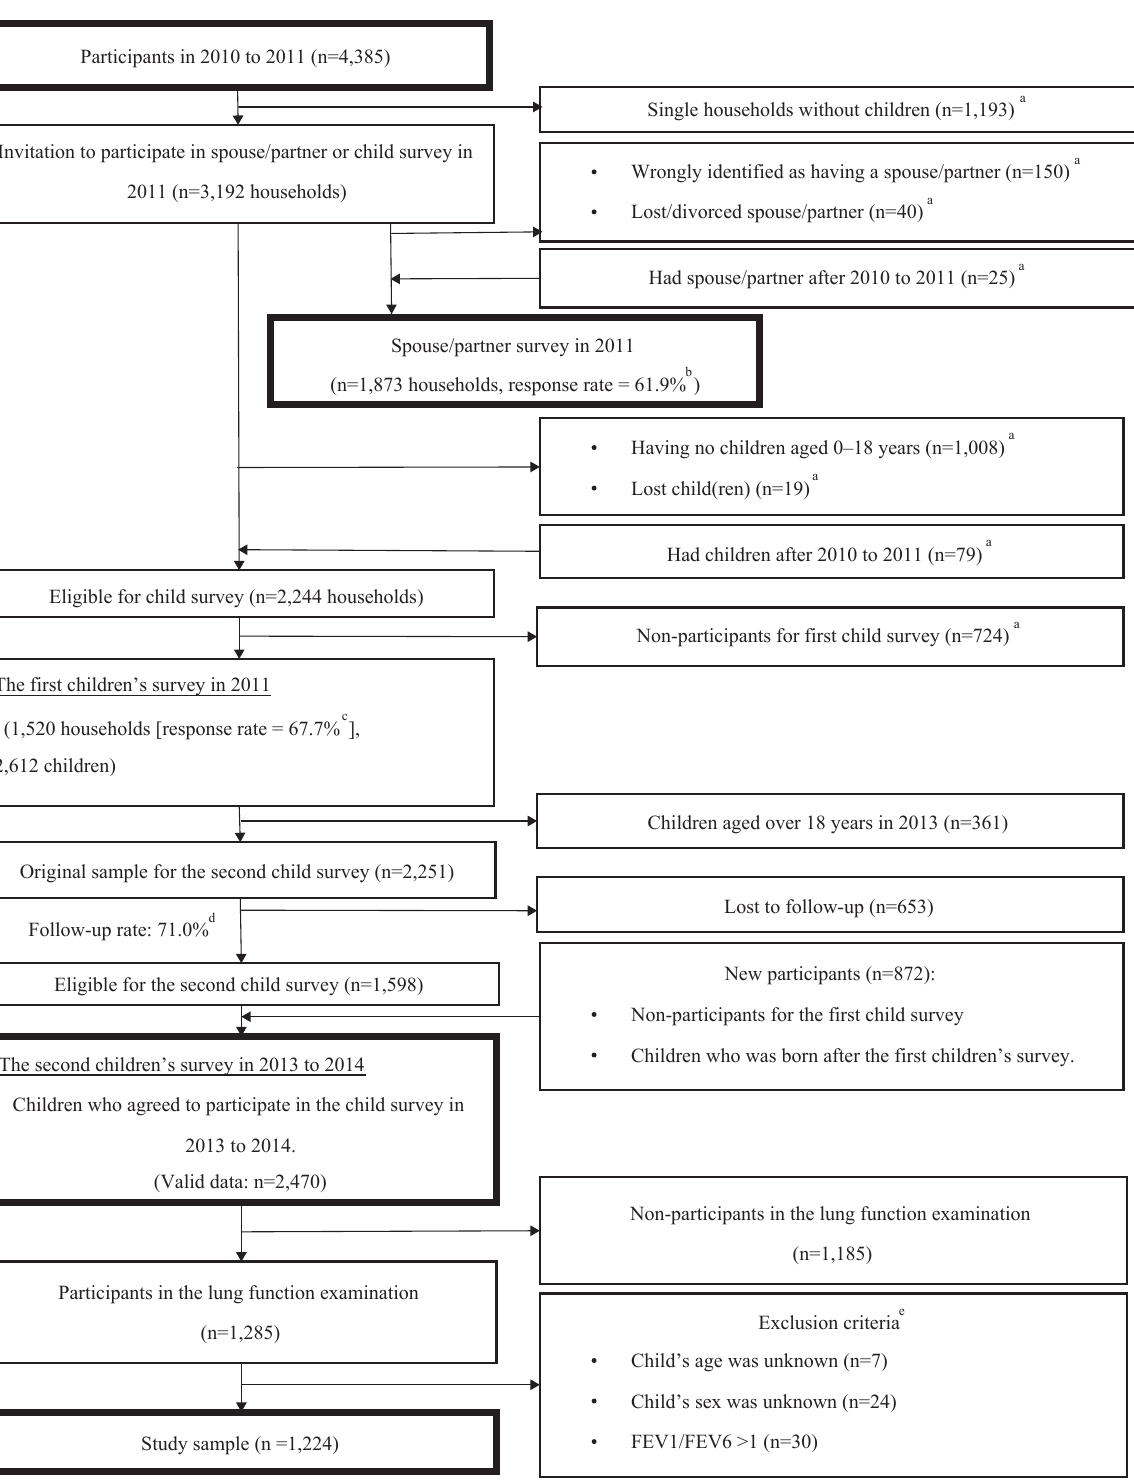
Figure 1. Sample fl owchart. a The unit was households. b 1,873 divided by 3,027. c 1,520 divided by 2,244. d 1,598 divided by 2,251. e There was no overlap of the two missing variables for child ’ s age and sex, and FEV1 / FEV6 >